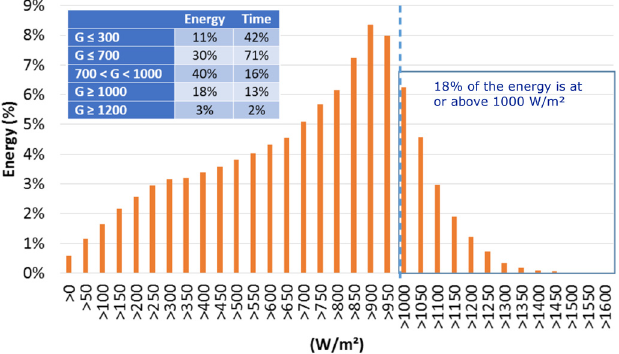
Fig. 6. Distribution of solar irradiation at 50W/m 2 bins, measured at 1-s time resolution at one of the eight Evaluation Sites reported in this paper, showing that a considerable fraction (18%) of the irradiation is at or above one sun or 1000W/m 2 irradiance.